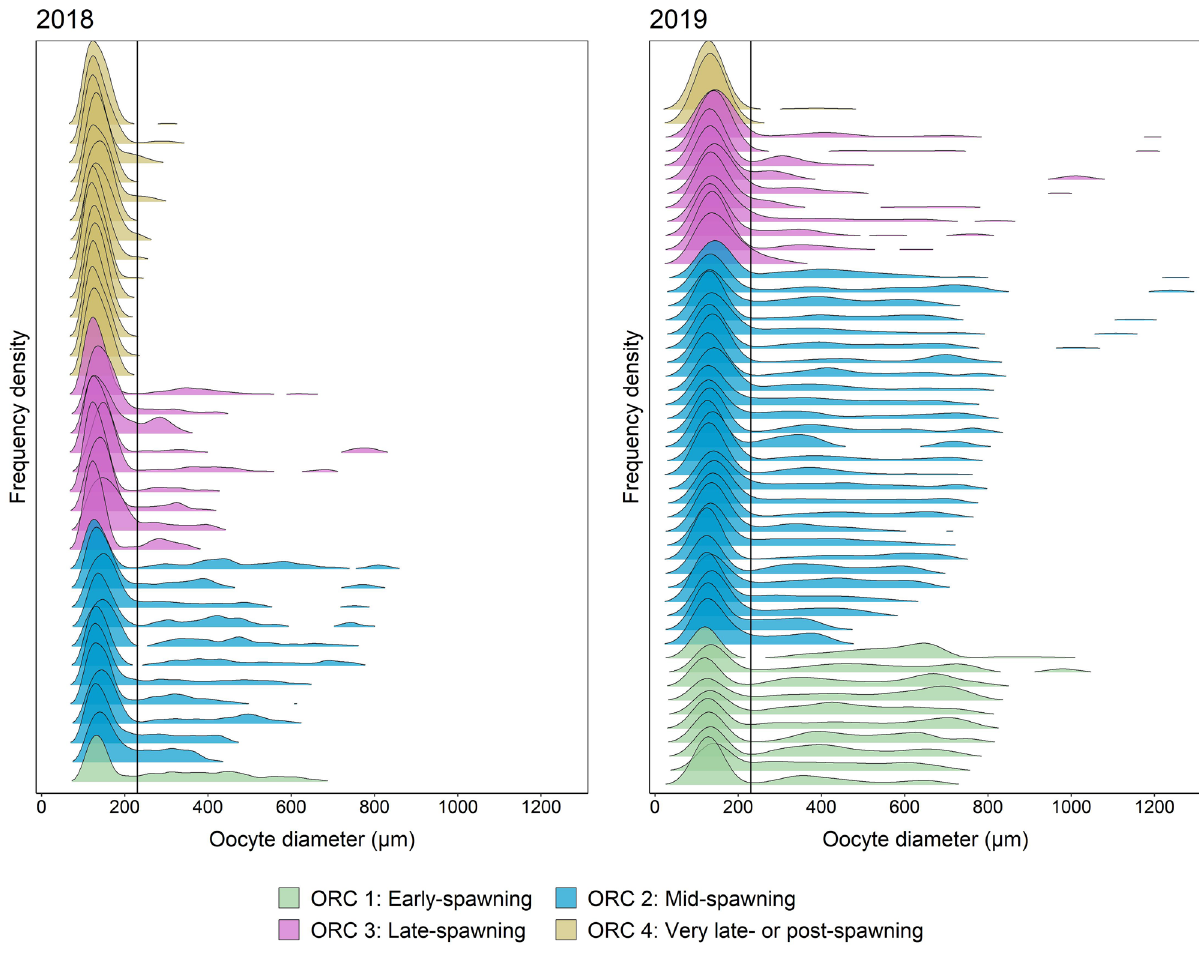
Figure 5. Smoothed oocyte size frequency distribution (OSFD) for each female used in the OPD analysis during the spawning period, according to oocyte ratio category. OSFD is organized in ascending order based on the maximum oocyte diameter within each ORC. The oocyte diameter for each female refer to the wholemount data analysis. The vertical line indicates the threshold value between PVOs and PVO4c (OD = 230